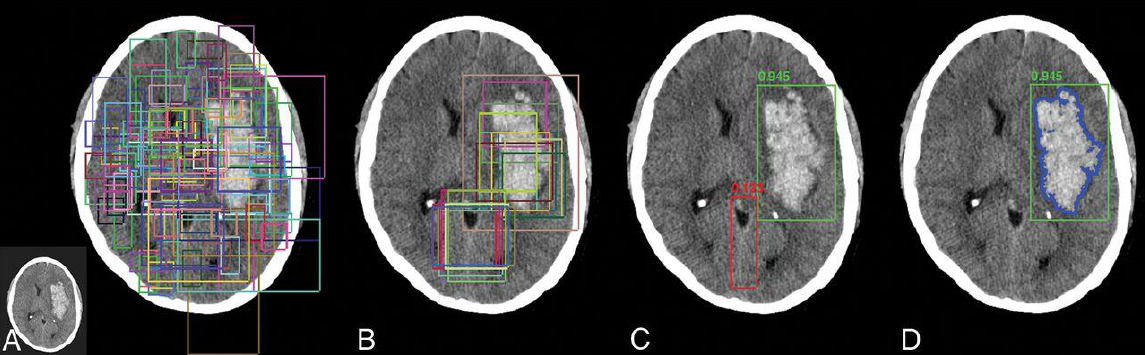
Figure 8. Overview of the mask R-CNN approach. ( A ), The bounding boxes indicates the presence of abnormality; ( B ), Generation of region; ( C ), Composite region proposals; and ( D ), Segmentation masks for hemorrhage region. Source [150].